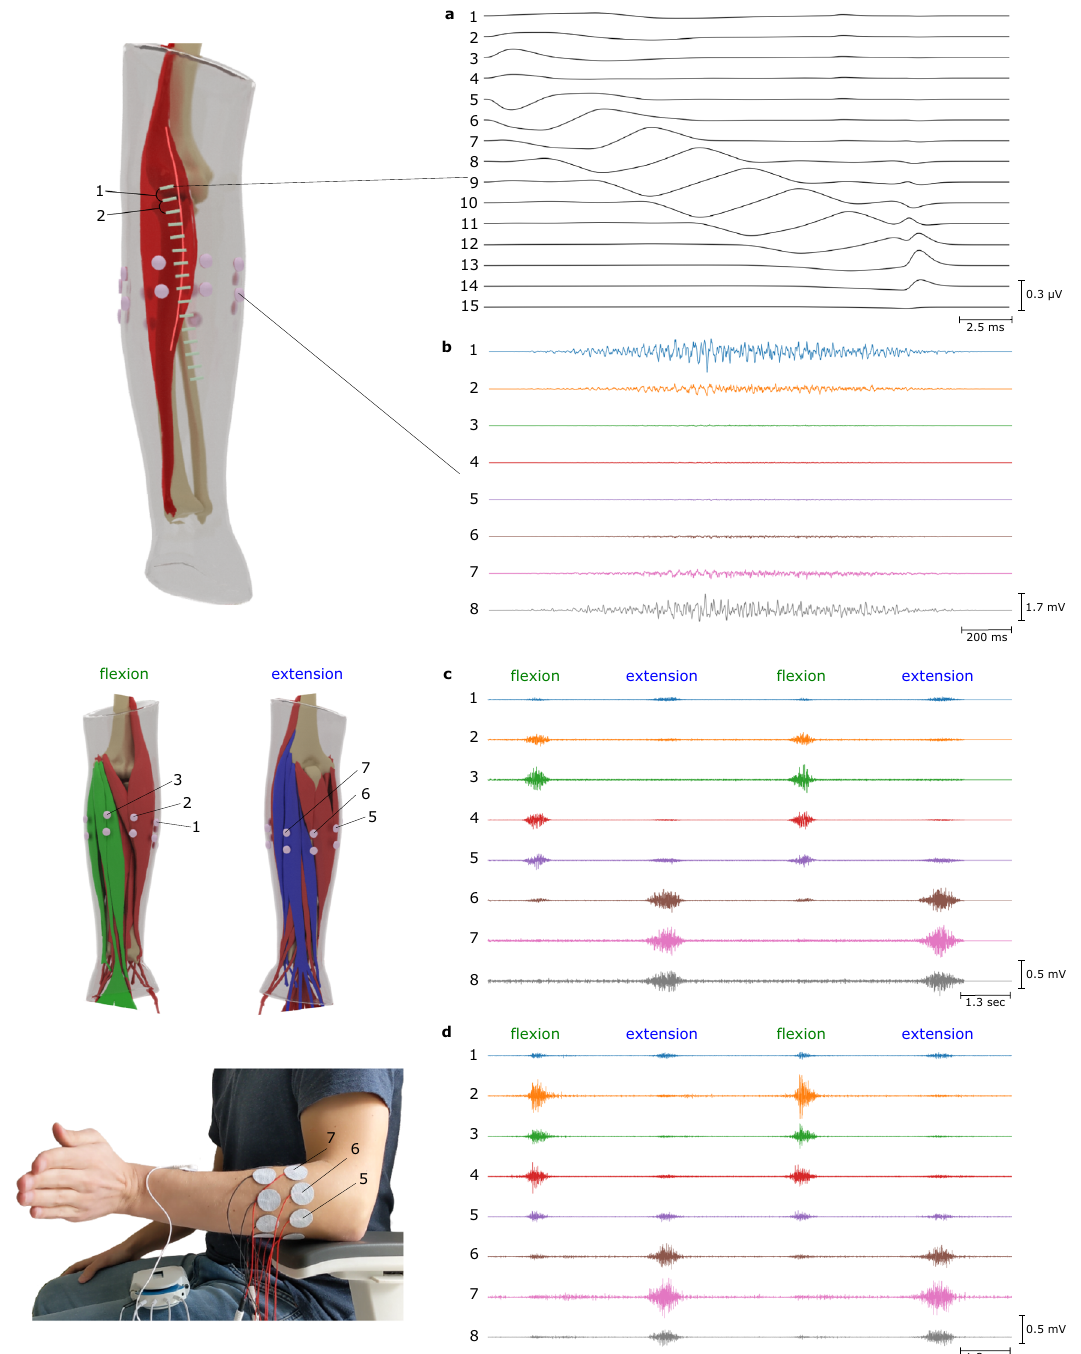
Fig. 3 | Simulation examples at multiple activation scales. a Single fi bre activa- tion in the Brachioradialis muscle measured by an electrode array with 15 differ- entialchannels. b 2-secondslongactivationoftheBrachioradialismuscle,reaching 100% of maximum voluntary contraction (MVC). 8 bipolar electrodes located